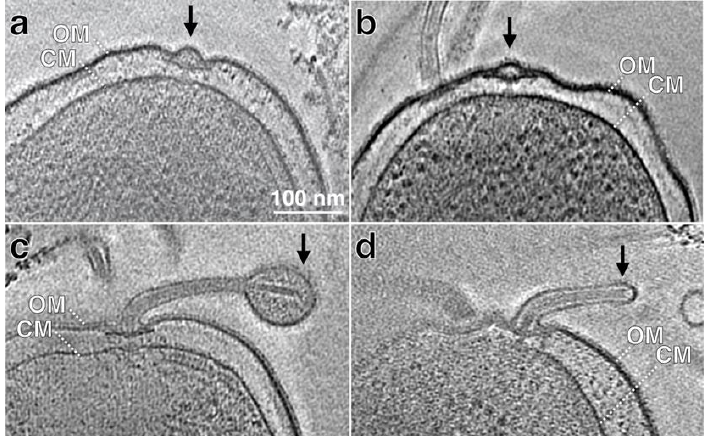
Figure 2. Cryo-ET reconstructions of intact cells show early stages of flagellar assembly and sheath formation. ( a , b ) Two representative sections from cryo-ET reconstructions of H. pylori cells show flagellar basal bodies without hook and filament. ( c , d ) Two representative sections from cryo-ET reconstructions of H. pylori cells show short flagellum. The outer (OM) and cytoplasmic membranes (CM) are indicated.